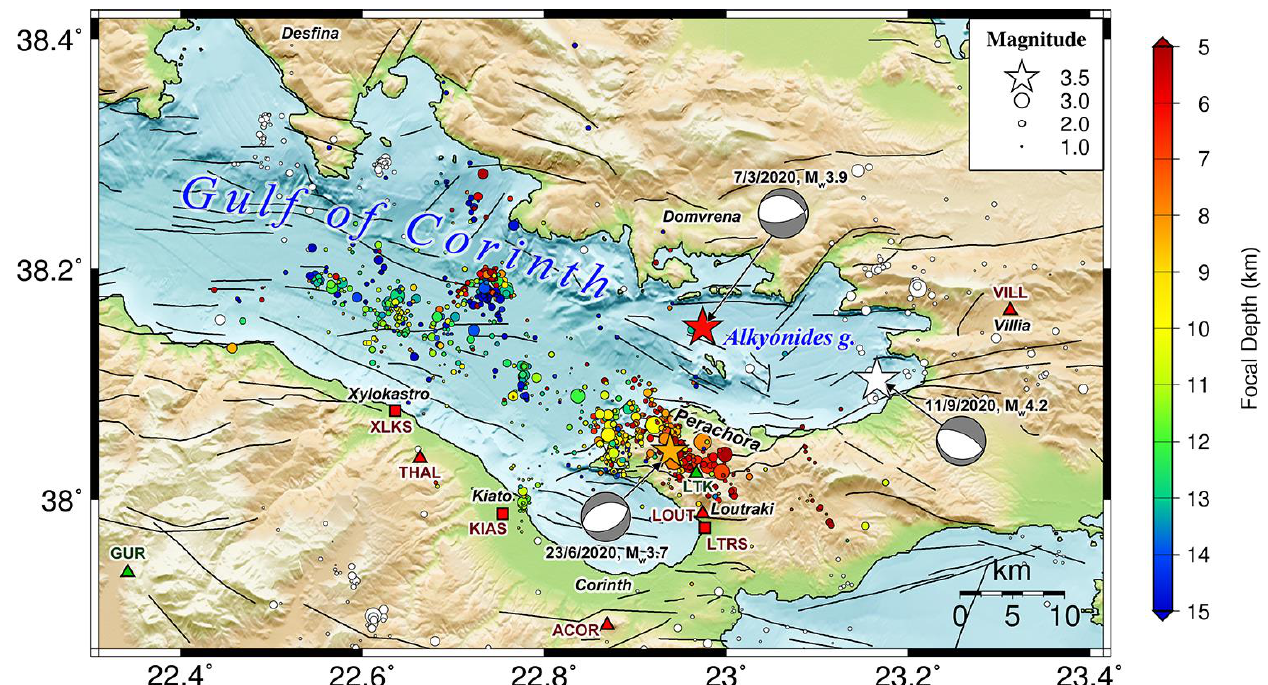
Figure 1. Area of study in the EGoC. Relocated seismicity for the period January 2020–June 2021, from the manual catalog of this study (CAT1), is presented with colors corresponding to the focal depth. Epicenters in the broader area with a white color are from the same period but not included in the catalog of this study. Events with magnitude M ≥ 3.5 are drawn with stars. Seismological (triangles) and accelerometric (squares) stations, belonging to HA ([46]; red) and HP ([47]; green) networks of the HUSN, which were operational during the study period, are also displayed on the map. Focal mechanisms of major events ( M w ≥ 3.7) are from the databases of the NKUA-SL, GI-NOA, and ISC (see also [29]). Fault lines are from the NOAFaults v4.0 database [48,49].